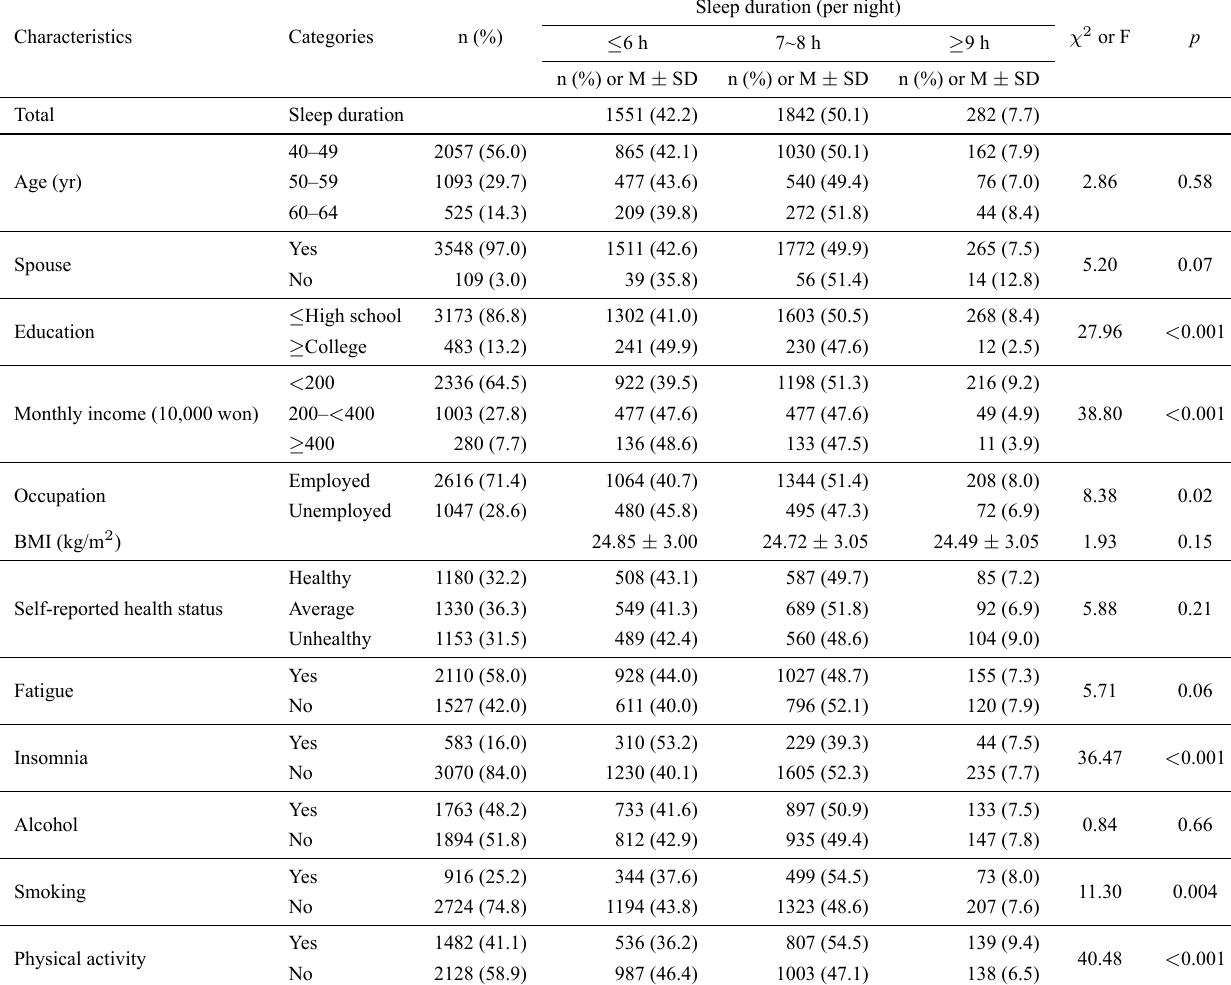
Table 1. Sleep duration according to participants’ characteristics (n =